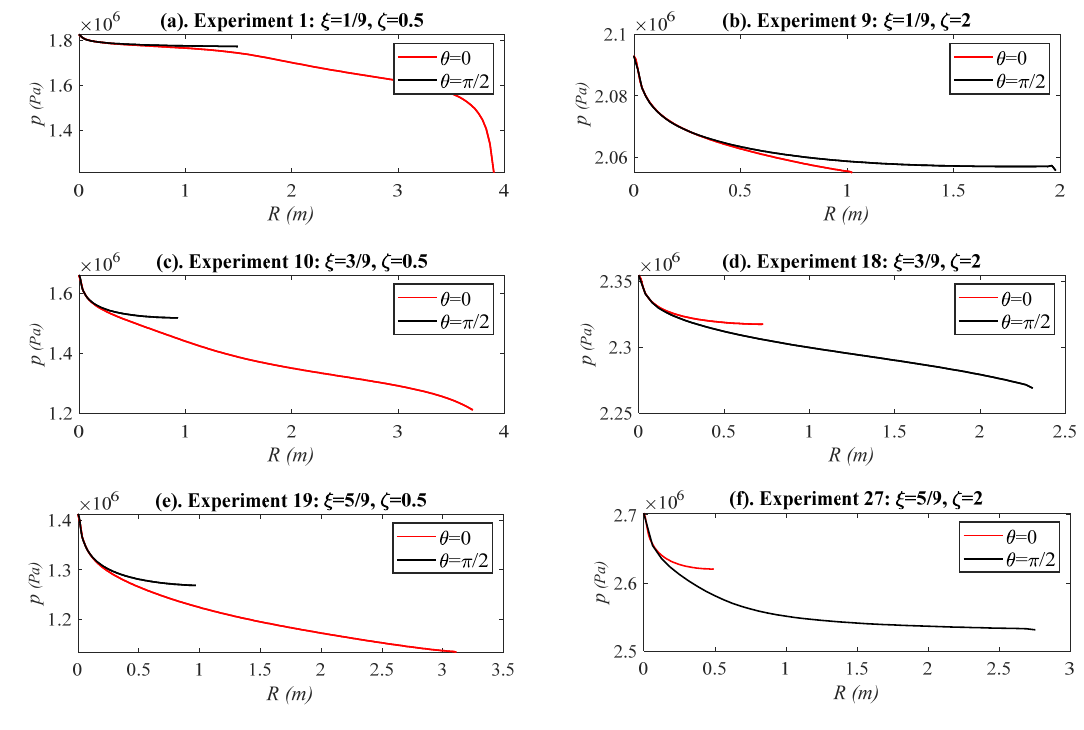
Figure 9. Comparison of fluid pressures along radial zones θ = 0 and θ = π /2 of experiments 1, 9, 10, 18, 19, 27.